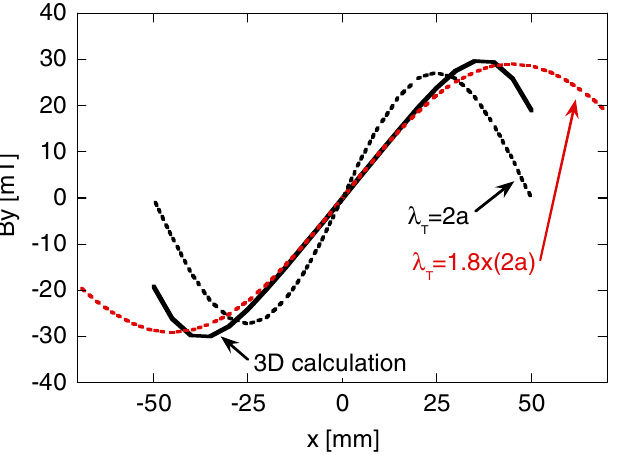
FIG. 12. (Color) Magnetic field distributions of the EF wiggler dedicated to beam focusing. The black solid line shows the magnetic field calculated with the 3D program, the black dotted ¼ 2 a , the hori- line shows that calculated with Eq. (4) for (cid:4) FIG. 13. (Color) Vertical field gradient as a function of the T zontal width of the EF wiggler, and the red dotted line shows that wiggler gap for EF wigglers with the same edge angle 2 (cid:1) but ¼ 1 : 8 (cid:3) ð 2 a Þ calculated with (cid:4) with different wiggler periods and magnet widths. The circles T and the squares indicate field gradients calculated with the 3D program and averaged over a wiggler period. The solid and the dashed lines show field gradients calculated with Eq. (5). See text for details.